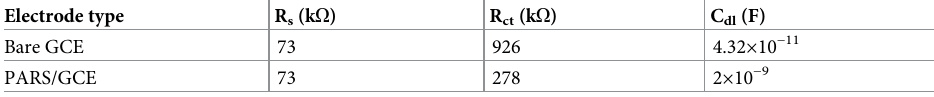
Table 1. Summary of the calculated values of selected